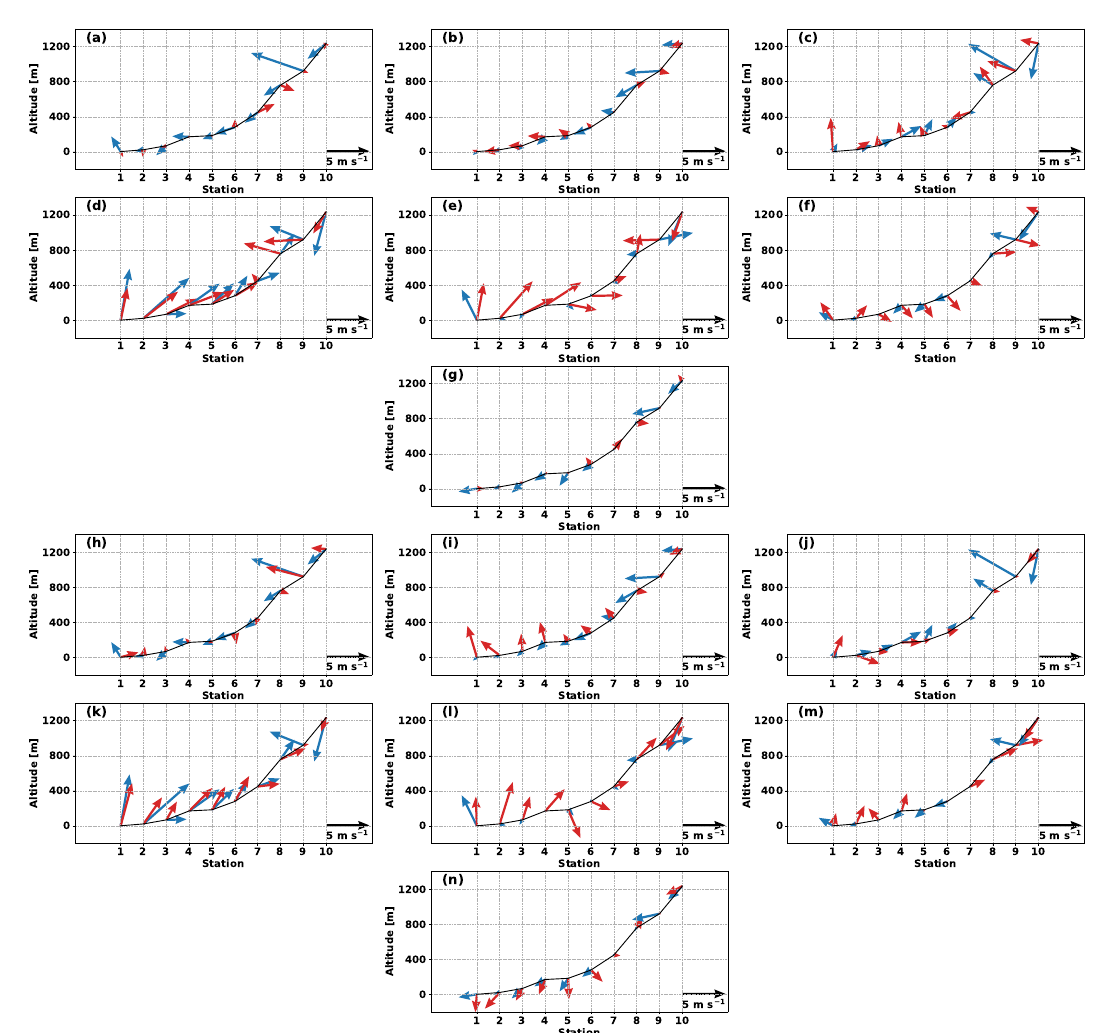
Figure 8. Observed (blue arrows) and D3 simulated (GrMRF and KFGS; red arrows) 10 m wind vectors (m s − 1 ) for 1 September 2004 at 03:00 LST ( a , h ), 06:00 LST ( b , i ), 09:00 LST ( c , j ), 12:00 LST ( d , k ), 15:00 LST ( e , l ), 18:00 LST ( f , m ), and 21:00 LST ( g , n ). LST: Local Solar